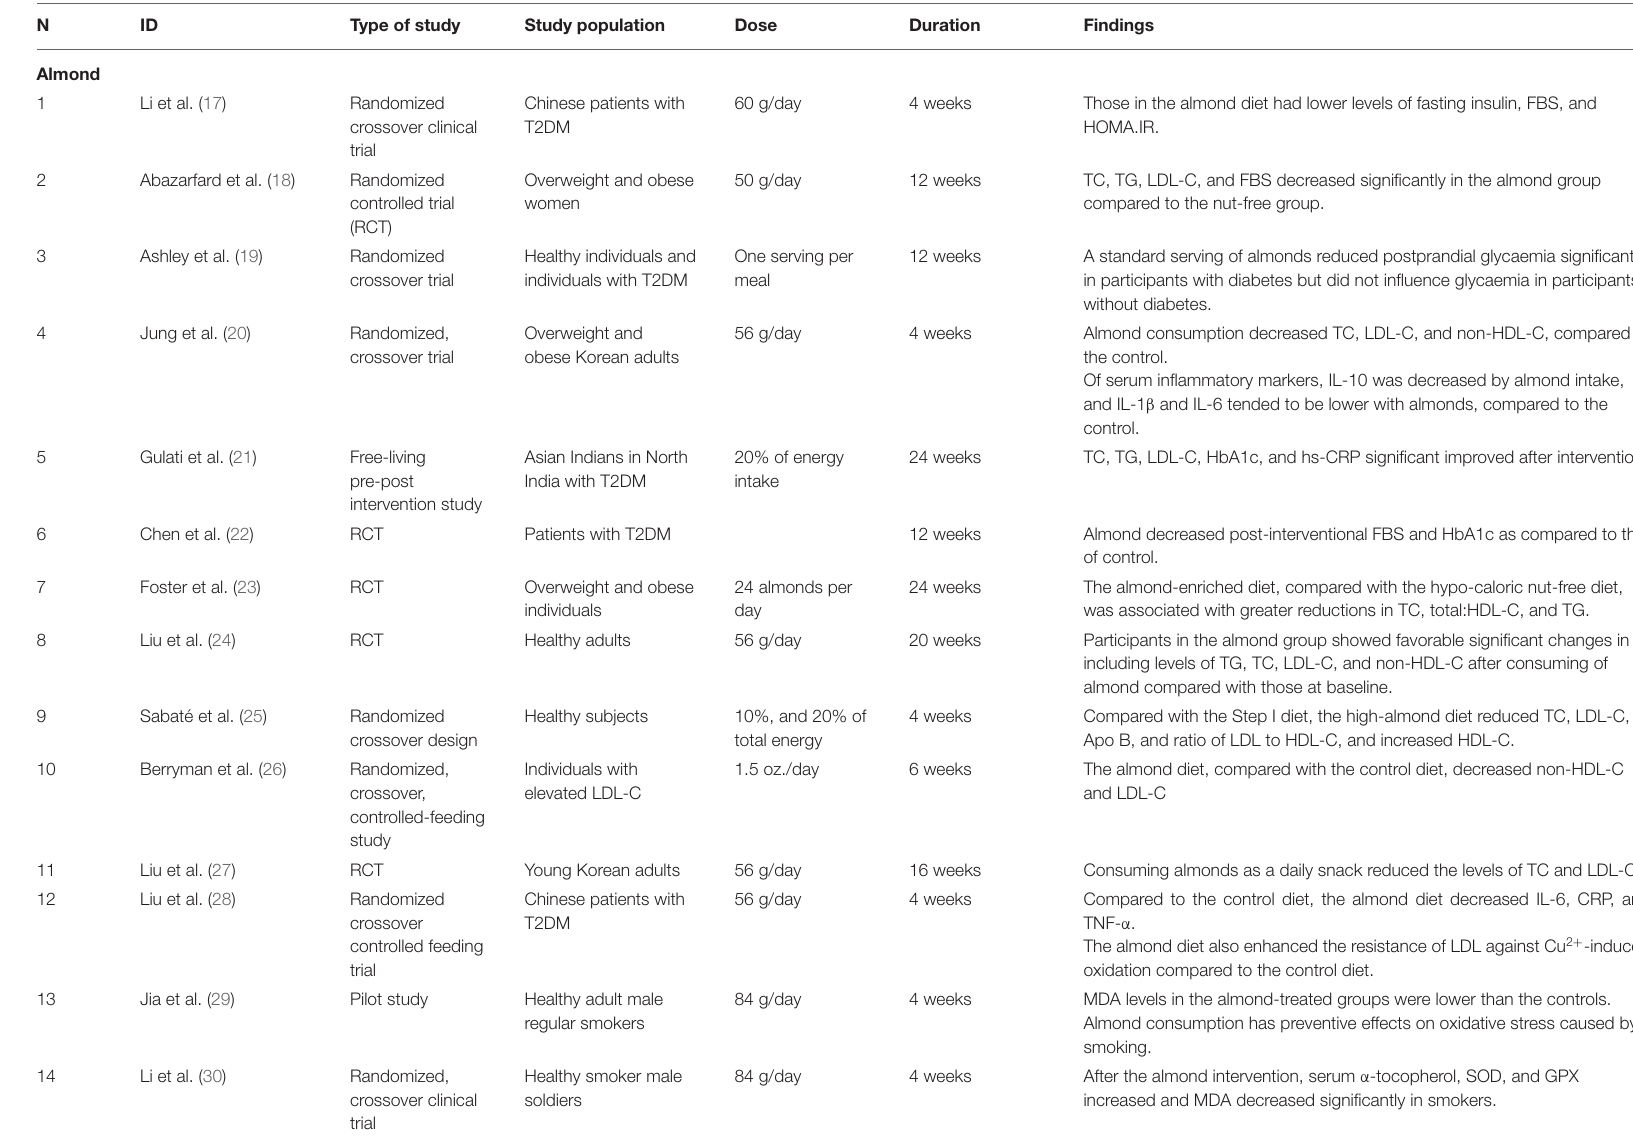
TABLE 1 | A summary of studies evaluating the effect of nuts supplementation on metabolic